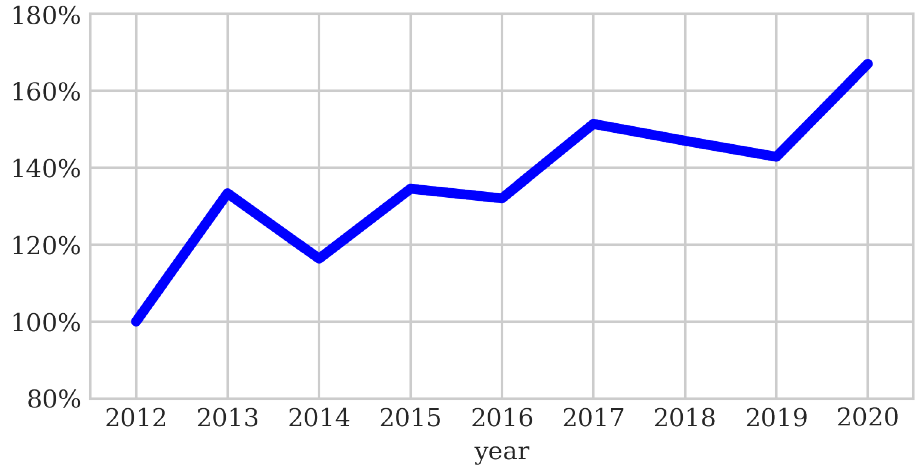
Figure 11. Revenue from non-transport services of DB Cargo Polska, normalized to 2012. Own study based on company